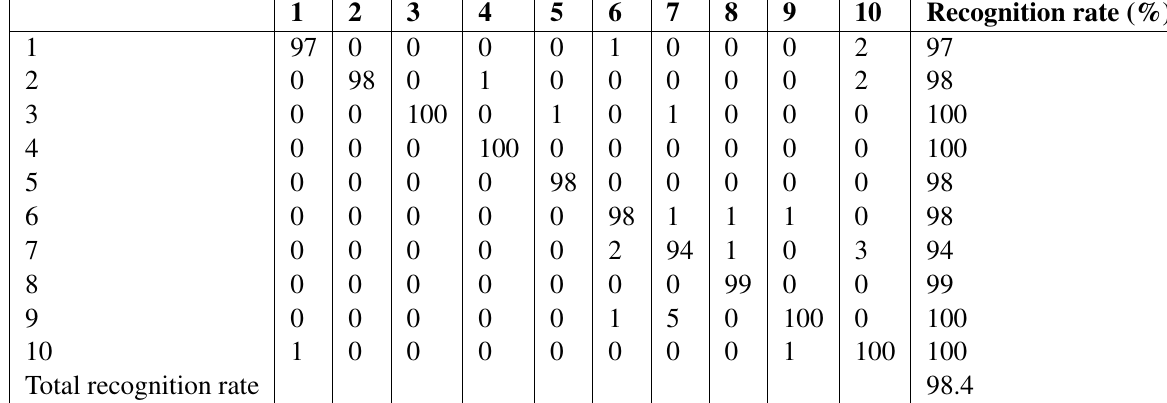
Table 2 Confusion matrix of 10 dynamic behaviour categories